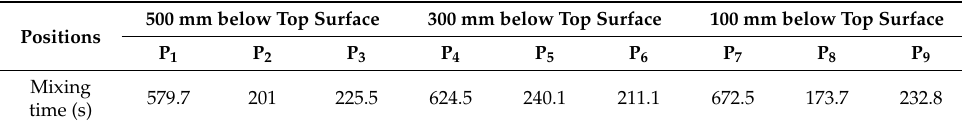
Figure 6. Variation of the dimensionless concentration of aluminum at three typical monitors: ( a ) monitors 500 mm below top surface; ( b ) monitors 300 mm below top surface; ( c ) monitors 100 mm below top surface. Table 2. Mixing time results for different monitors.